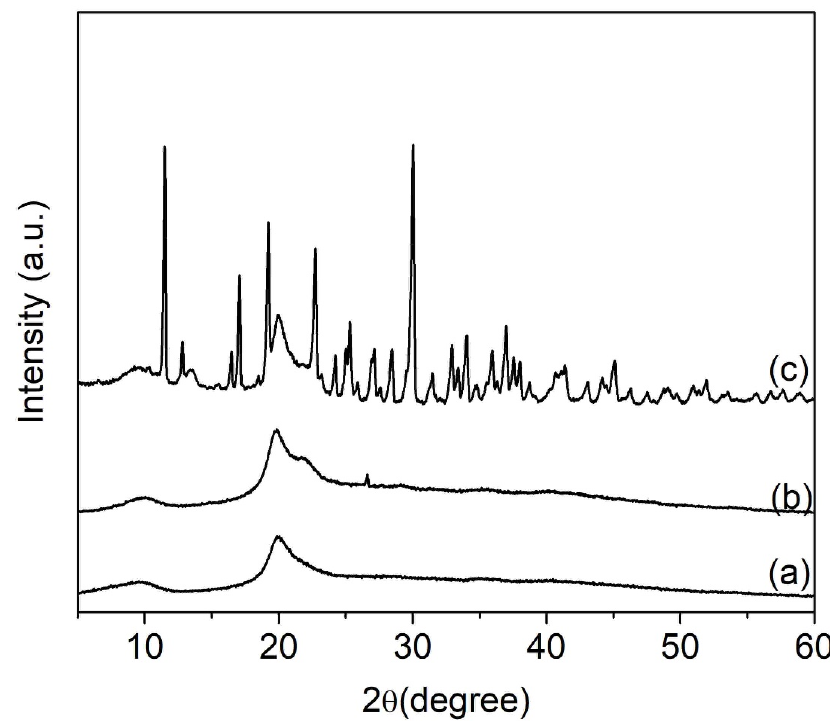
Figure 3. XRD patterns of ( a ) pristine, ( b ) NCS2 and ( c ) NCS7 chitosan samples.